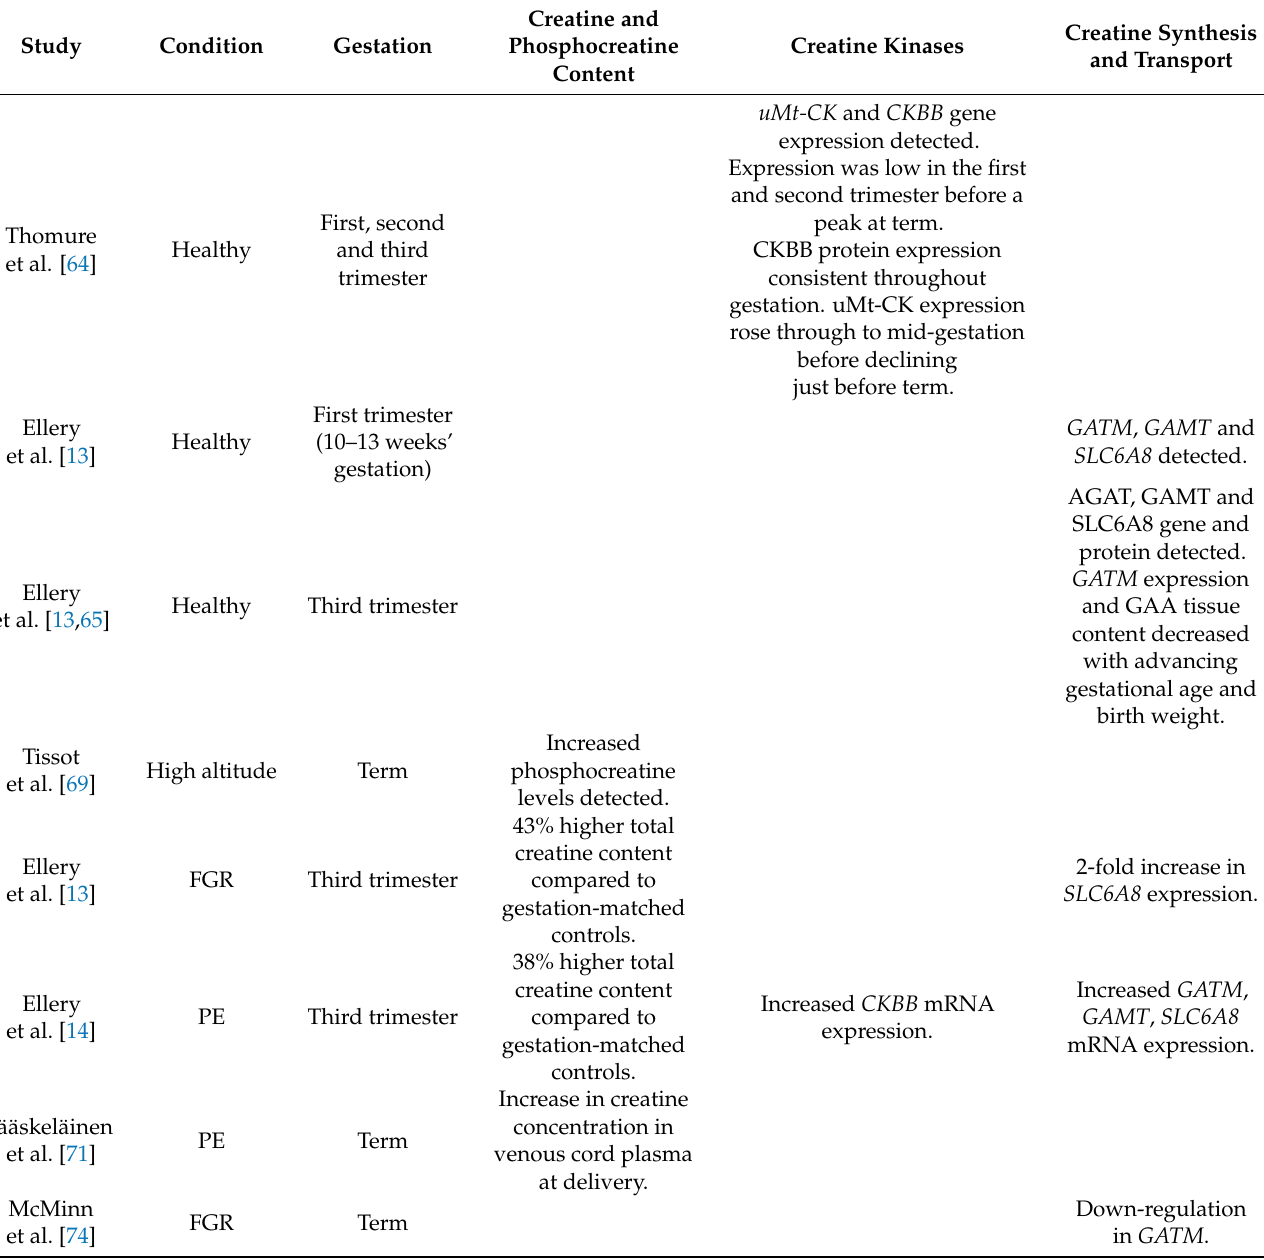
Table 2. Summary of Creatine Metabolism in the Human